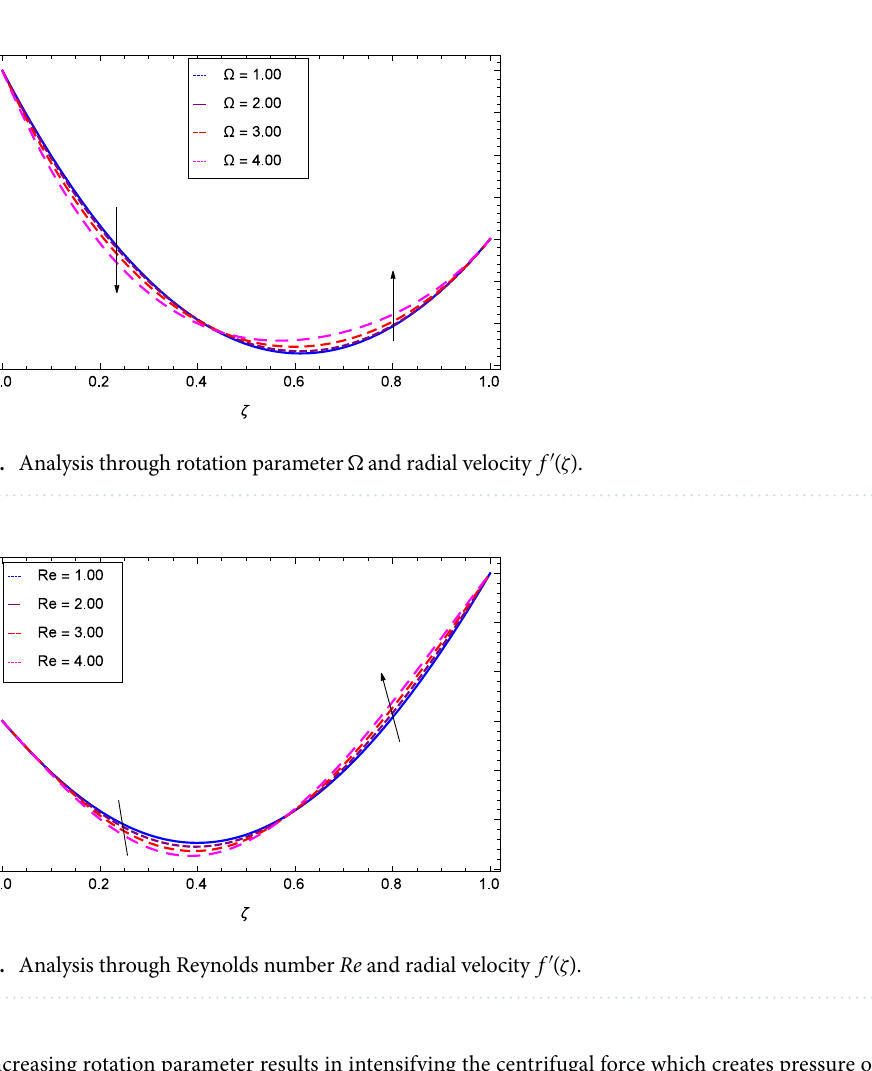
Figure 13 projects that temperature falls down due to the increase in magnetic field parameter M . The rotation parameter (cid:31) influence is represented in Fig. 14 where the temperature is enhanced